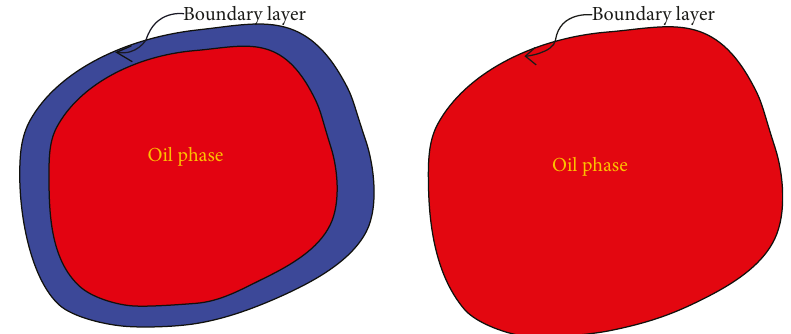
Figure 1: The in fl uence of the boundary layer on the fl ow of tight throat.